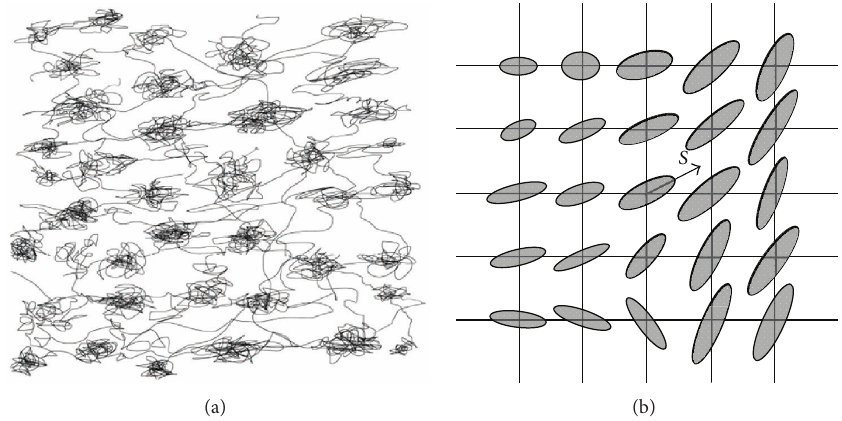
Figure 3: Schematic image of initial state of liquid-like to rubber-like transition (a) and its model representation